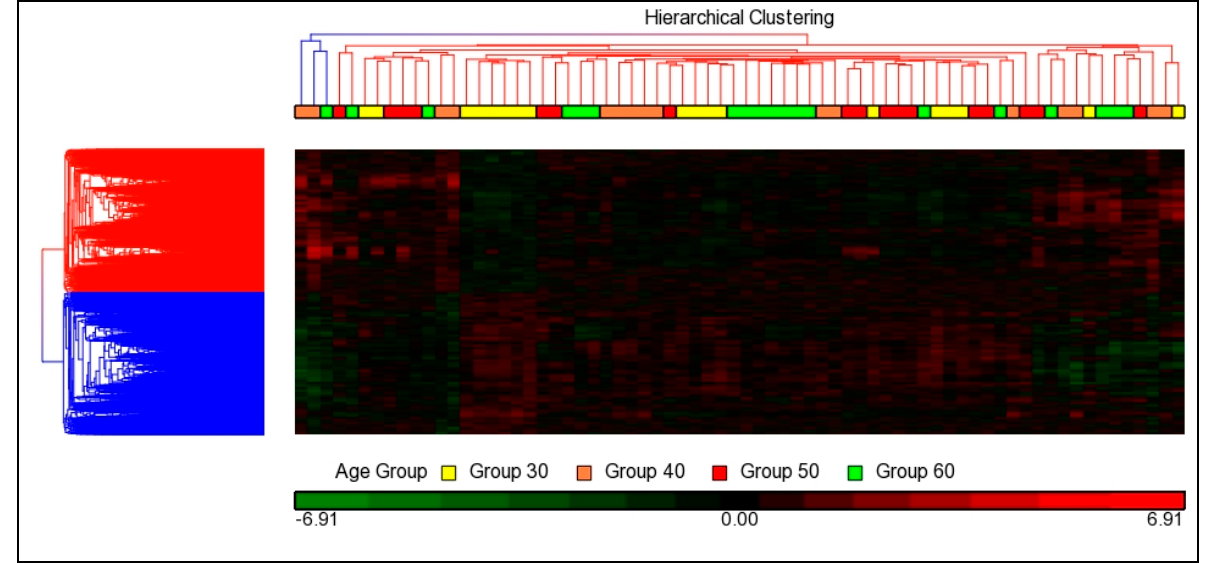
Figure 3. Unsupervised hierarchical cluster analysis of gene expression in age group; age 30 (yellow), age 40 (orange), age 50 (red), and age 60 (green).